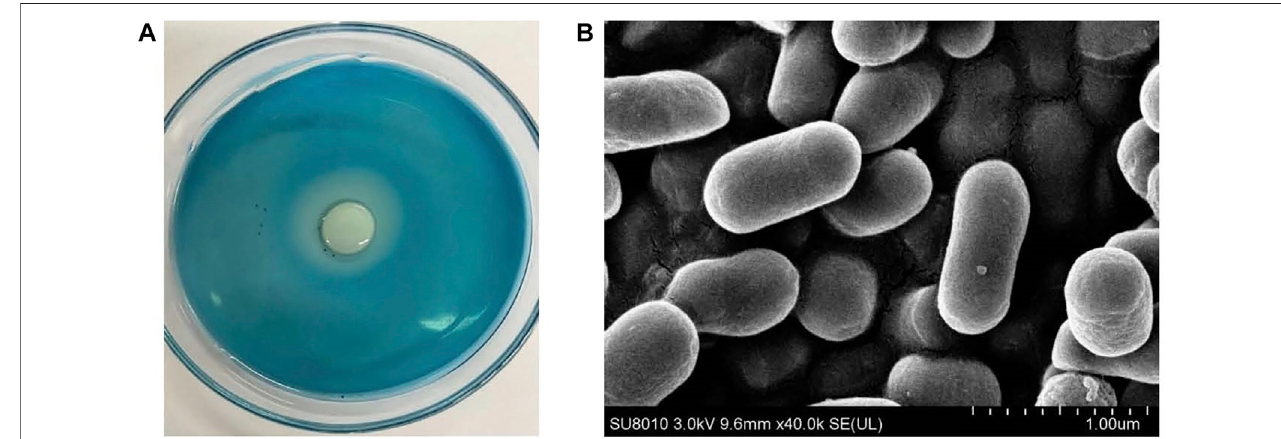
FIGURE 1 | Transparent zone formed by G6-4B on the plate containing blue dextran (A) and scanning electron micrograph (B)